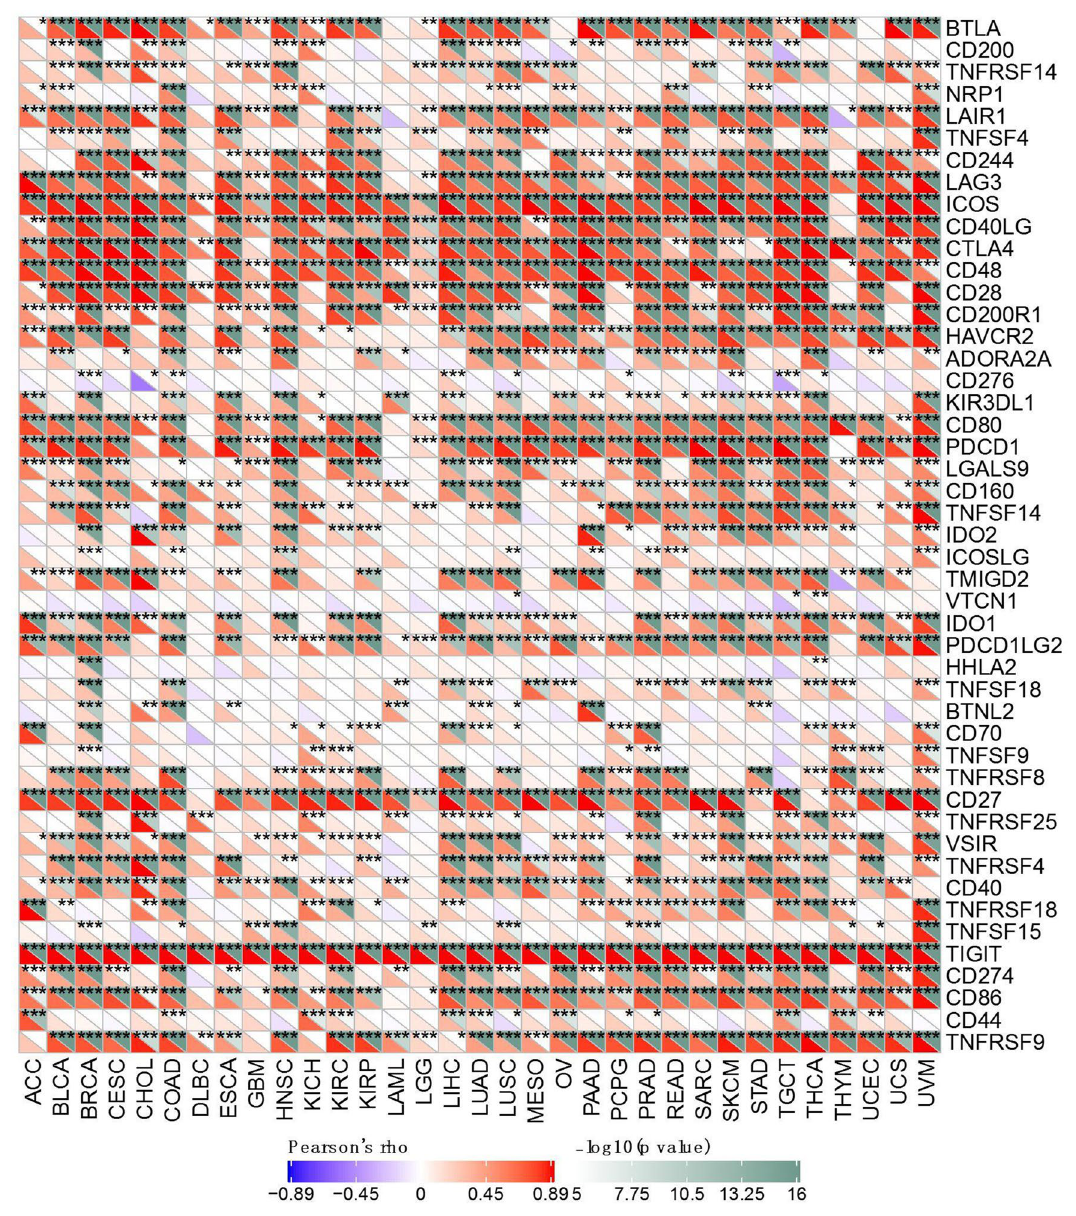
Figure 6. Correlation of TIGIT expression with expression of immune checkpoint genes across 33 cancer types. *p < 0.05, **p < 0.01, and ***p <